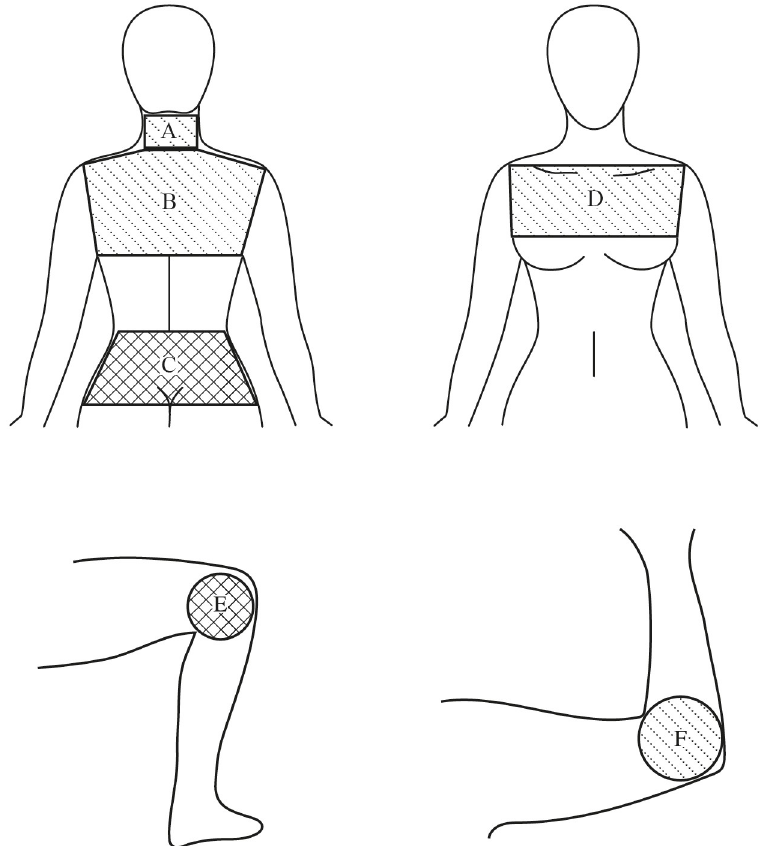
Fig 1. Regions of interest used in the study. A: Neck; B: Upper back; C: Lower back; D: Chest; E: Medial knee; F: Lateral elbow. Regions in which significant differences between groups were obtained are represented by bold lines.